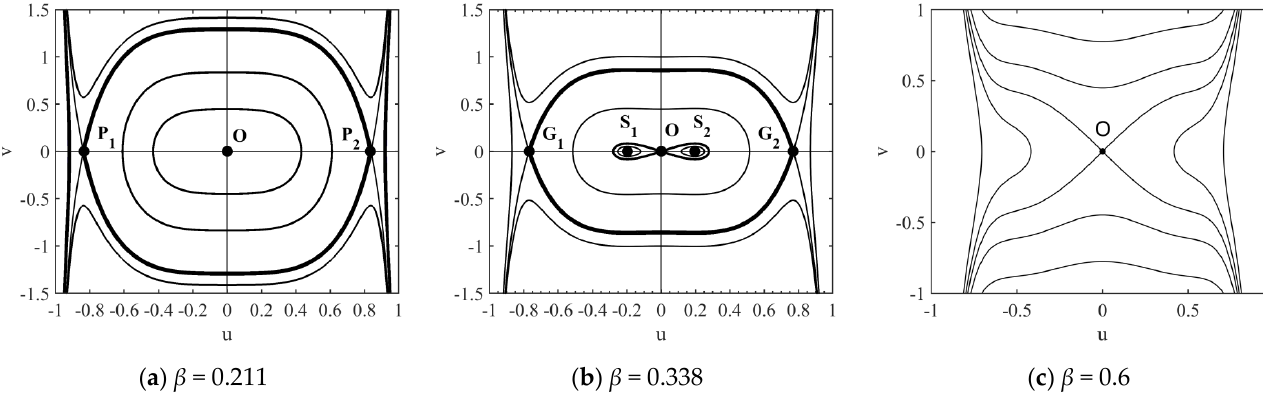
Figure 3. Orbits of the unperturbed system (4) under different values of parameter β .